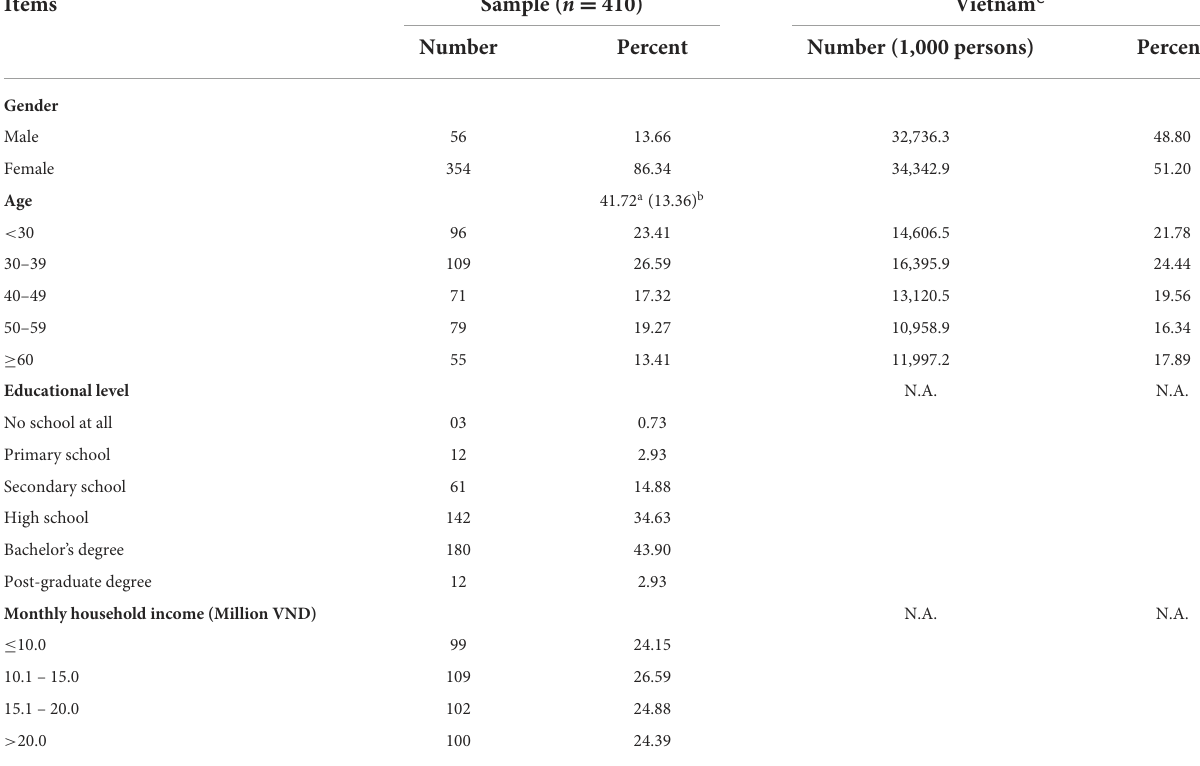
TABLE 4 Socio-demographic characteristics of the sample ( n = 410).